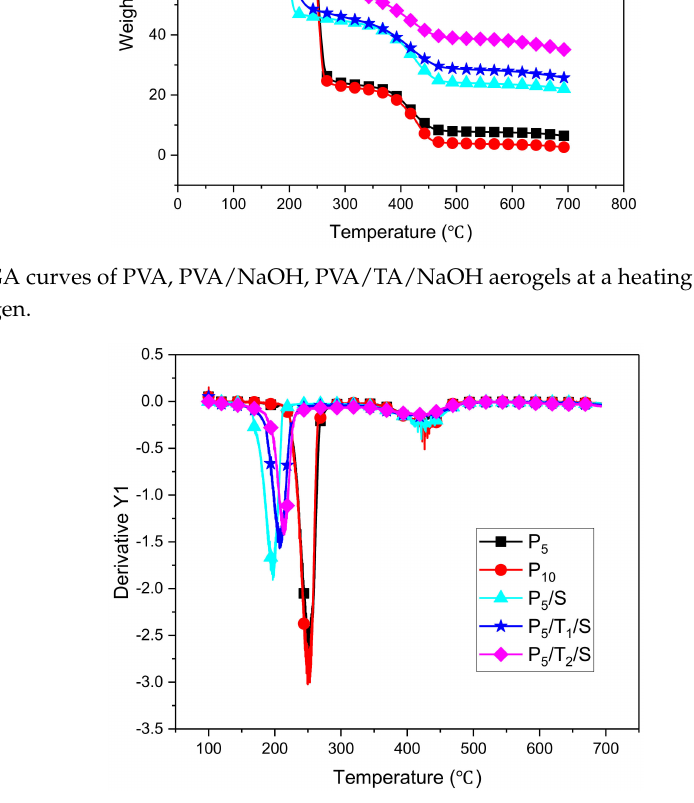
Figure 5. TGA curves of PVA, PVA/NaOH, PVA/TA/NaOH aerogels at a heating rate of 10 ◦ C/min under nitrogen. Table 3. TGA data of freeze dried PVA, PVA/NaOH, PVA/TA/NaOH